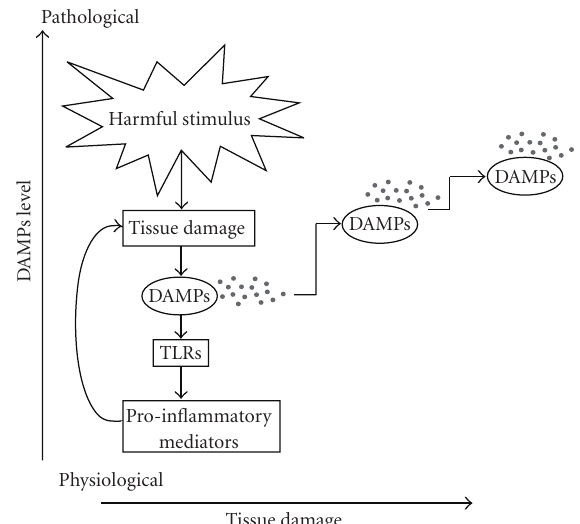
Figure 4: The “damage chain reaction.” Harmful stimuli, including pathogens, injury, heat, autoantigens, tumor, and necrotic cells, cause tissue damage. Endogenous danger signals are generated and induce a pro-inflammatory cascade by activating TLRs. In turn, pro-inflammatory mediators are upregulated and trigger further tissue damage leading to increasing DAMPs levels. Thus a vicious cycle is sustained and may result in chronic inflammation and